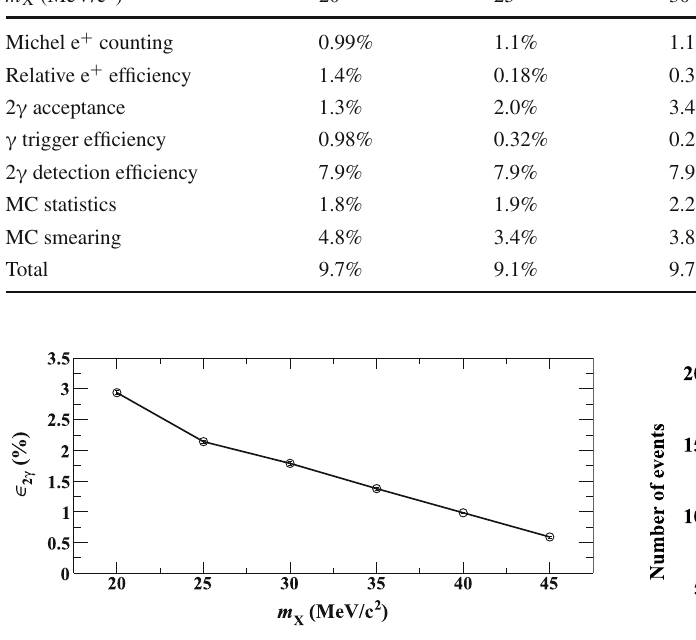
Fig. 15 (cid:6) 2 γ (see the text for the definition) versus m X for τ X = 20 ps